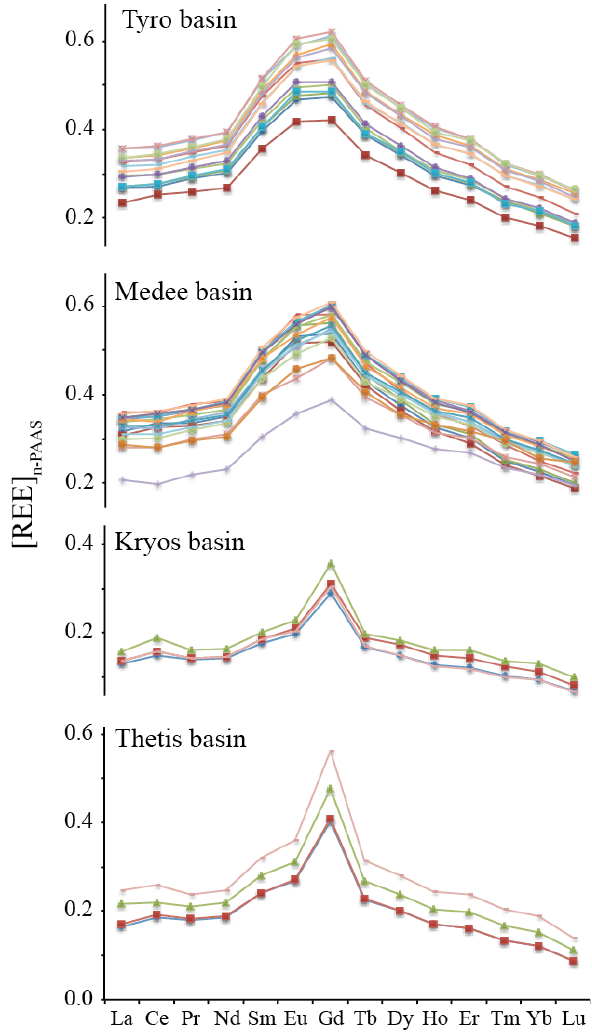
Fig. 3. Shale-normalised REE patterns of the analysed sediments from different basins. Analyses of sediments from the Tyro and Medee basins were carried out on the WS fraction, whereas analyses of sediments from the Kryos and Thetis basins were carried out on the FWSS fraction. For further information, see the text.